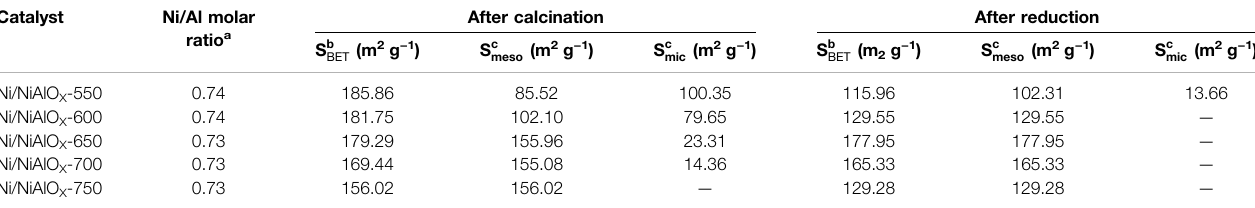
TABLE 1 | Ni/Al molar ratio and surface properties of Ni/NiAlO X catalysts with different calcination temperatures. Catalyst Ni/Al molar After calcination ratio a